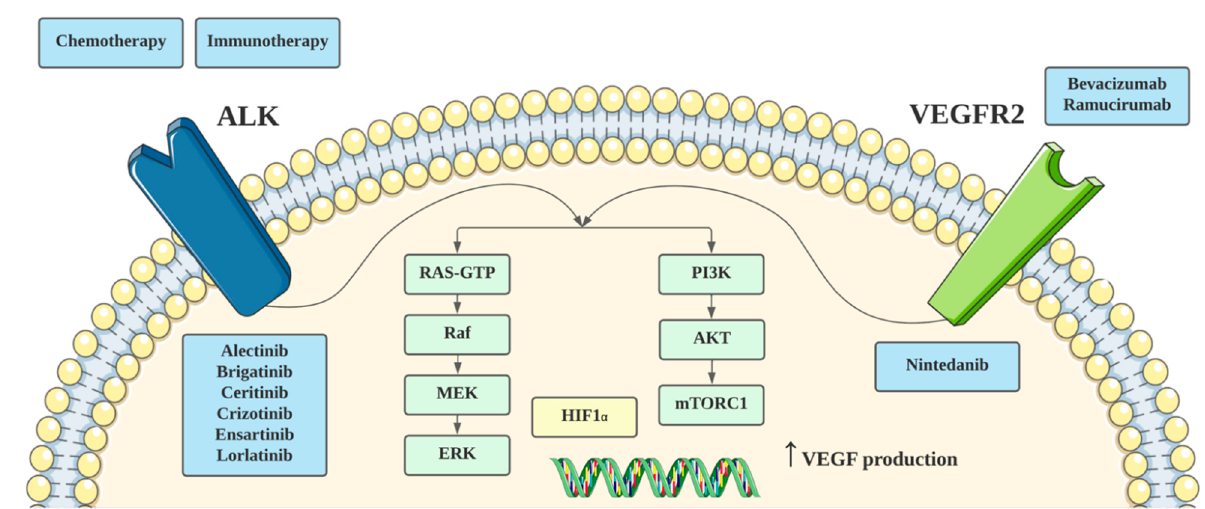
Figure 2. Inhibition of and potential cross-talk between the VEGF and ALK pathways.